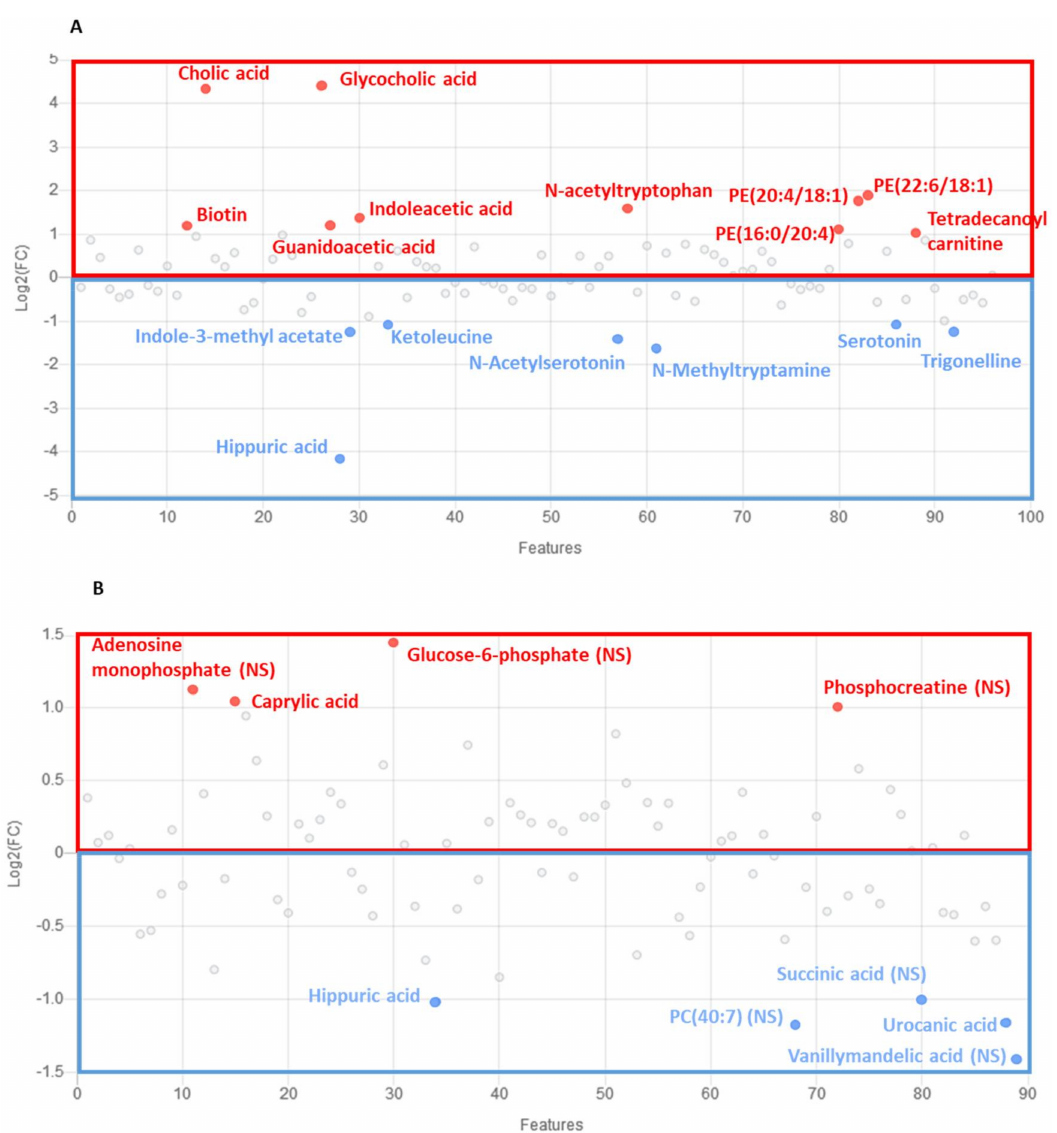
Figure 8. Metabolites as potential biomarkers of serum ( A ) and soleus ( B ) in Klf10 KO vs. WT mice. Metabolites are selected with a criteria of 2-fold change in regulation and p -value < 0.05. NS identify metabolites with two-fold increase and no significant p -value. In red are metabolites upregulated, and in blue are metabolites